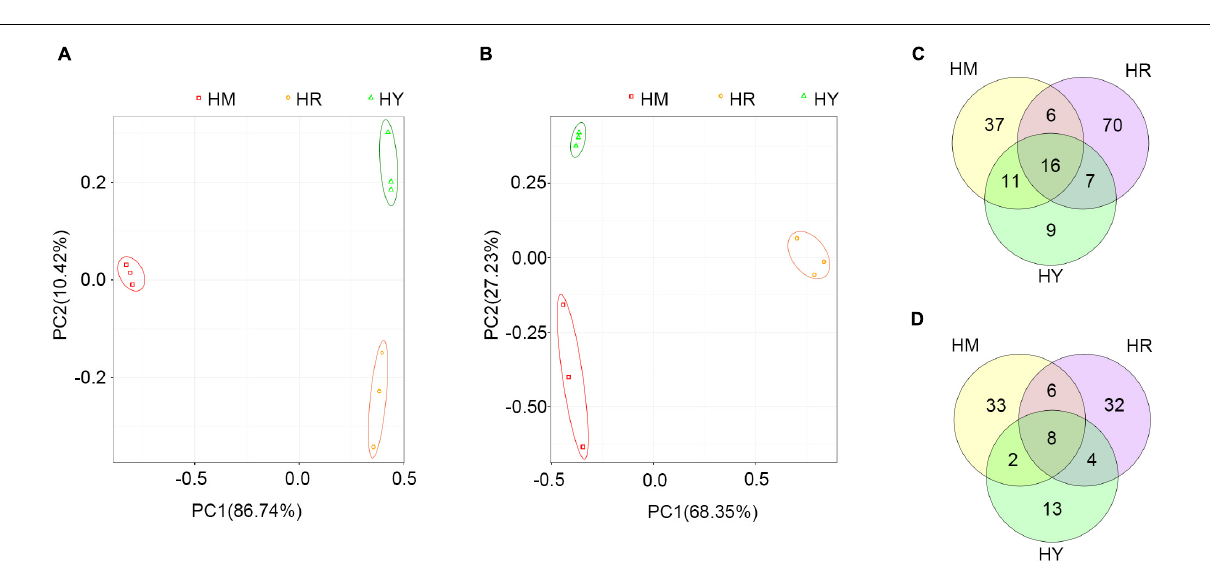
FIGURE 5 | The PCA analyses and Venn diagram analysis in the intestine of adult H. axyridis fed with different diets. (A,B) PCA analyses of bacteria (A) and fungus (B) at OUT. (C,D) The overlap of bacterial OTU (C) and fungal OTU (D)